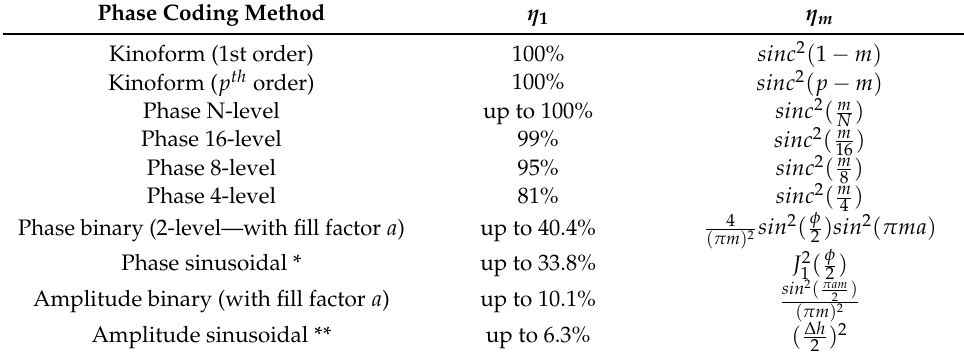
Table 1. The maximal values of diffraction efficiency of structures η 1 corresponding to different coding types and the numerical equations describing the efficiency in different orders of